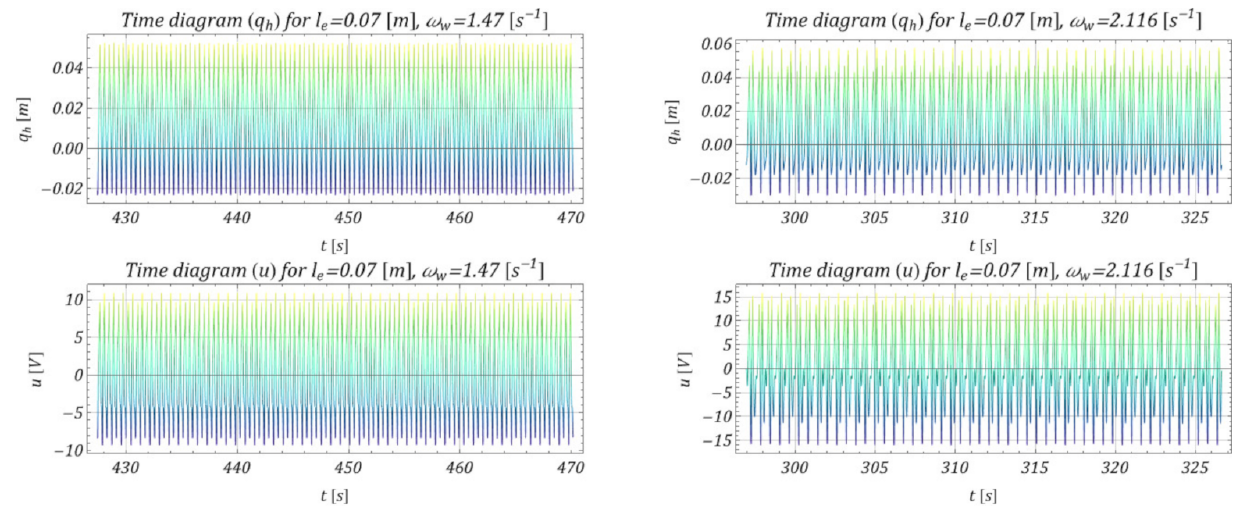
Figure 15. Phase diagrams related to selected solutions—periodic solutions for l e = 0.07 m.